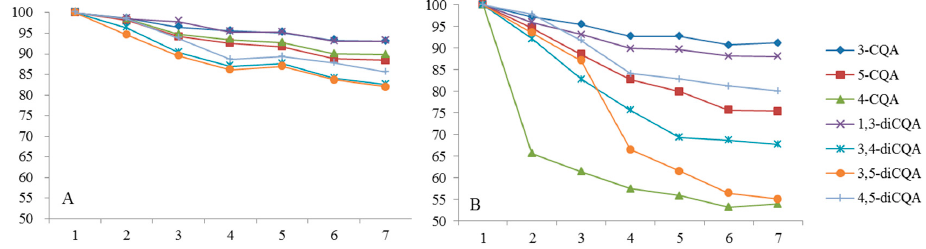
Figure 6. Stability of CQAs in transparent bottle at room temperature. ( A ) 50% ( v / v ) aqueous methanol; ( B ) Methanol.